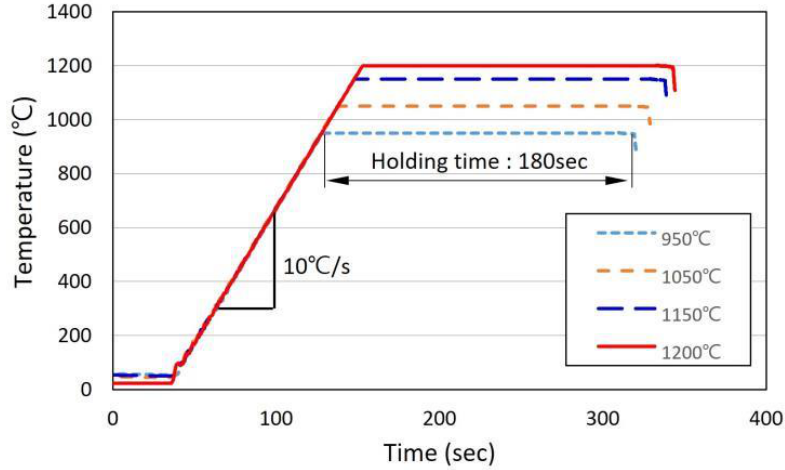
Figure 1. Heating cycles used for hot compression tests.